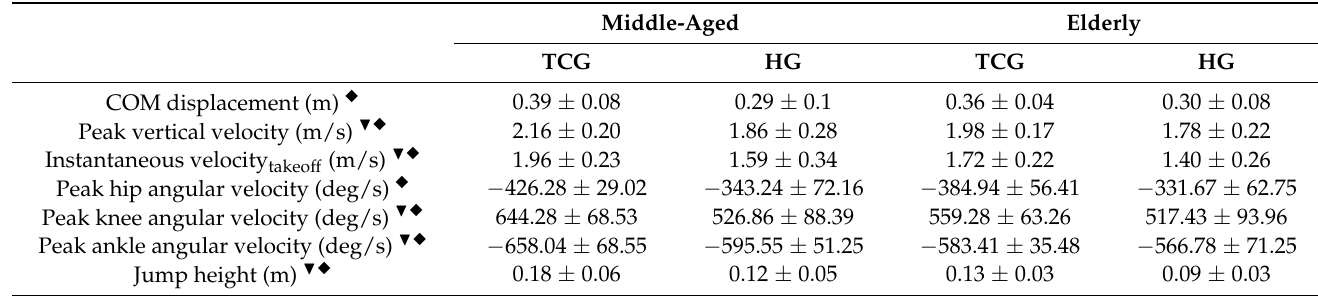
Table 1. Kinematics data during the take-off phase. Middle-Aged